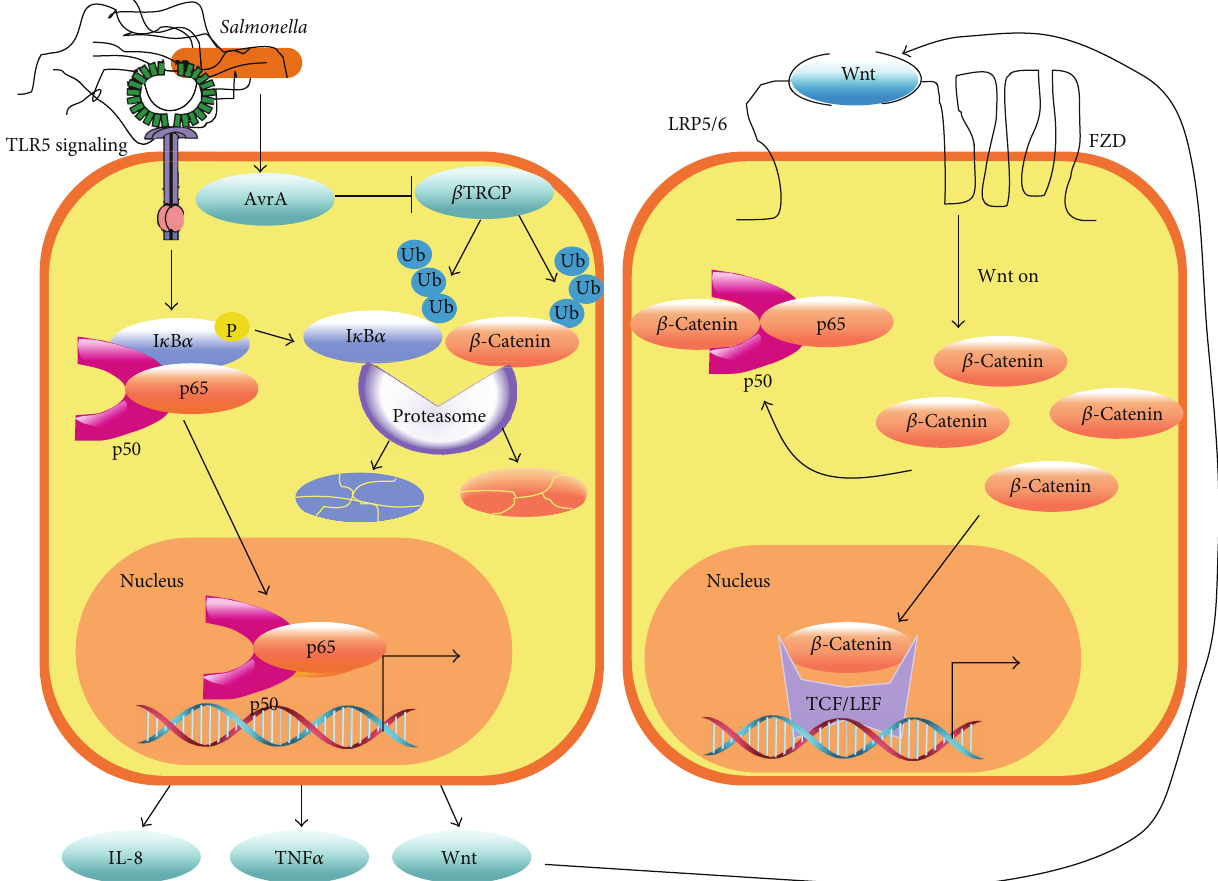
Figure 2: 𝛽 -Catenin is an antagonist of the NF- 𝜅 B pathway. In colon epithelial cells, Salmonella induces IL-8, TNF 𝛼 , and Wnt expression via NF- 𝜅 B activation. Moreover, the Salmonella typhimurium deubiquinating effector AvrA stabilizes I 𝜅 B 𝛼 and 𝛽 -catenin. This step enhances 𝛽 - catenin activity and at the same time inhibits NF- 𝜅 B by stabilizing its inhibitor. The expression of Wnt in the first stage of infection stimulates Wnt/ 𝛽 -catenin pathway. The stabilized 𝛽 -catenin then interacts with the NF- 𝜅 B p50 subunit, decreasing its transcriptional activity. While NF- 𝜅 B activity is inflammatory, its inhibition by 𝛽 -catenin activation constitutes a mechanism to reduce